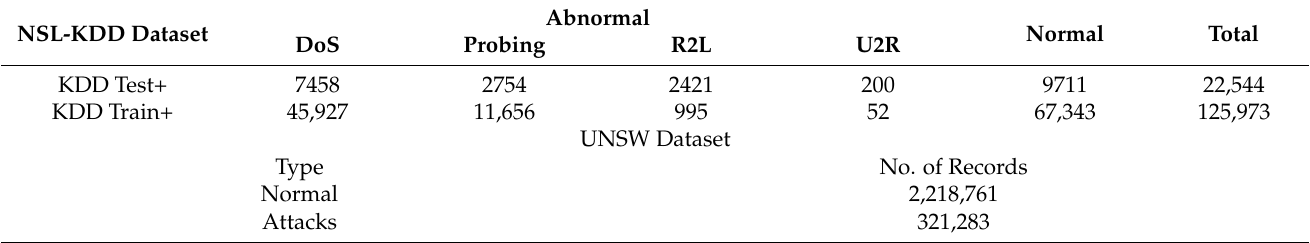
Table 1. NSL-KDD dataset and UNSW